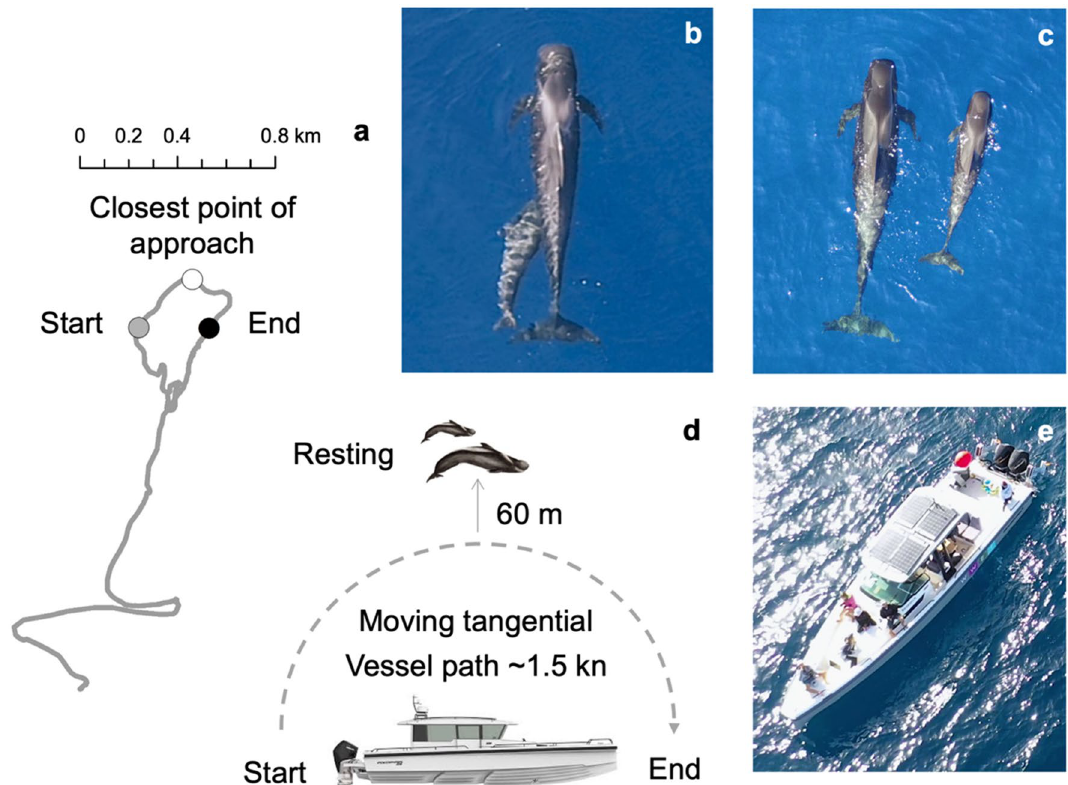
Figure 2. Methodological approach used during the experiments. ( a ) Vessel path recorded during a treatment scenario (example focal follow with electric engine), ( b , c ) aerial vantage point of a nursing and resting pilot whale mother-calf pair, ( d ) schematic diagram of treatment (electric and petrol engine) scenarios with 15 min duration approaches beginning > 200 m distance away and transiting in parallel/tangential to the whales; note that during the control scenario the vessel was stationary > 200 m with the engine in neutral, and ( e ) the hybrid whale-watch vessel with electric and petrol engines. Photographs were taken by Patricia